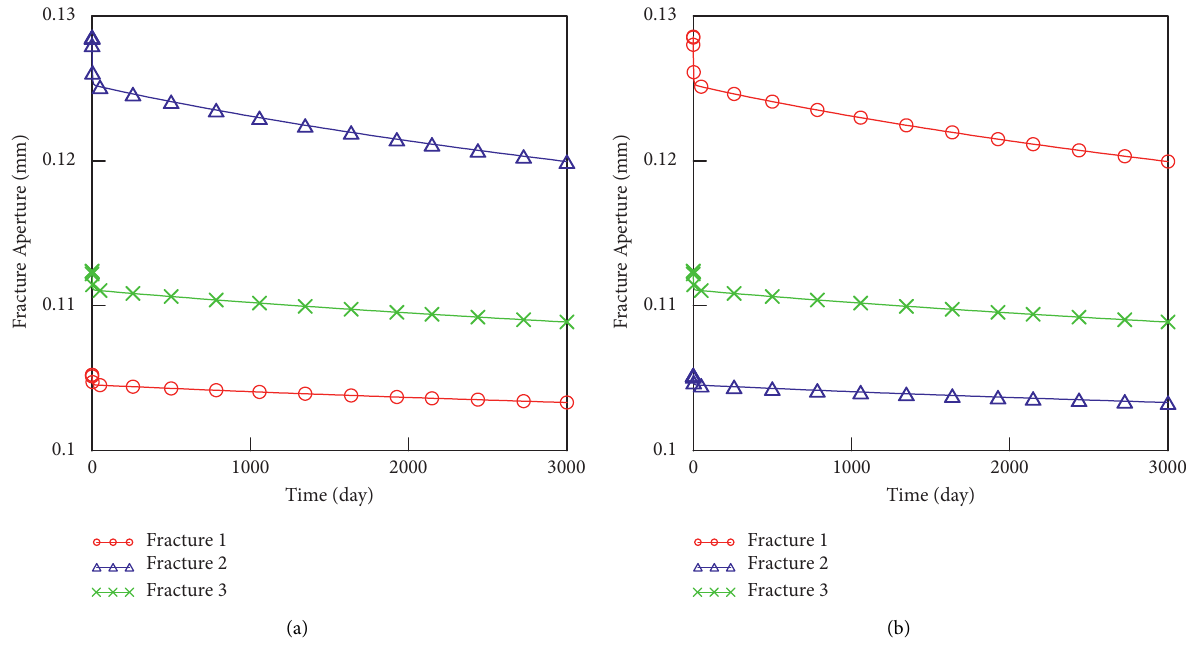
Figure 13: Effect of initial stress anisotropy on fracture aperture: (a) σ